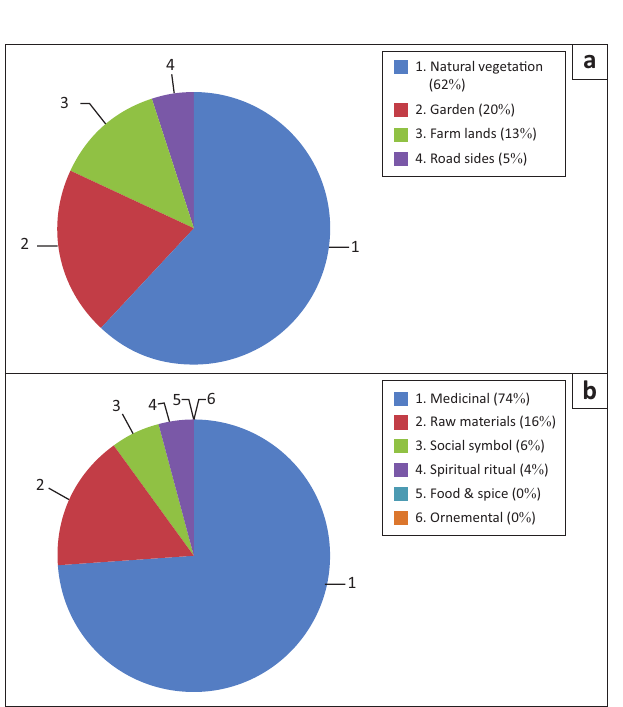
FIGURE 3: Distribution of 45 identified plant species among botanical families.